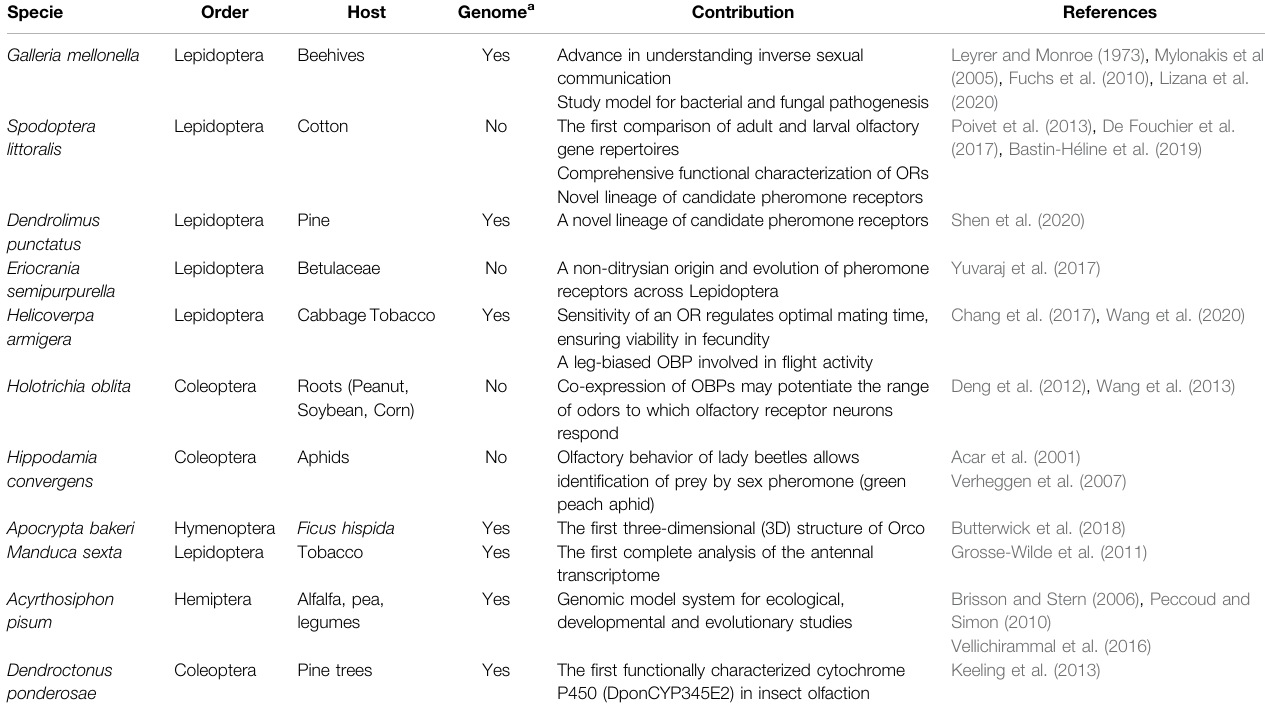
TABLE 1 | Summary of early non-model insects and their contribution to olfactory physiology in the last